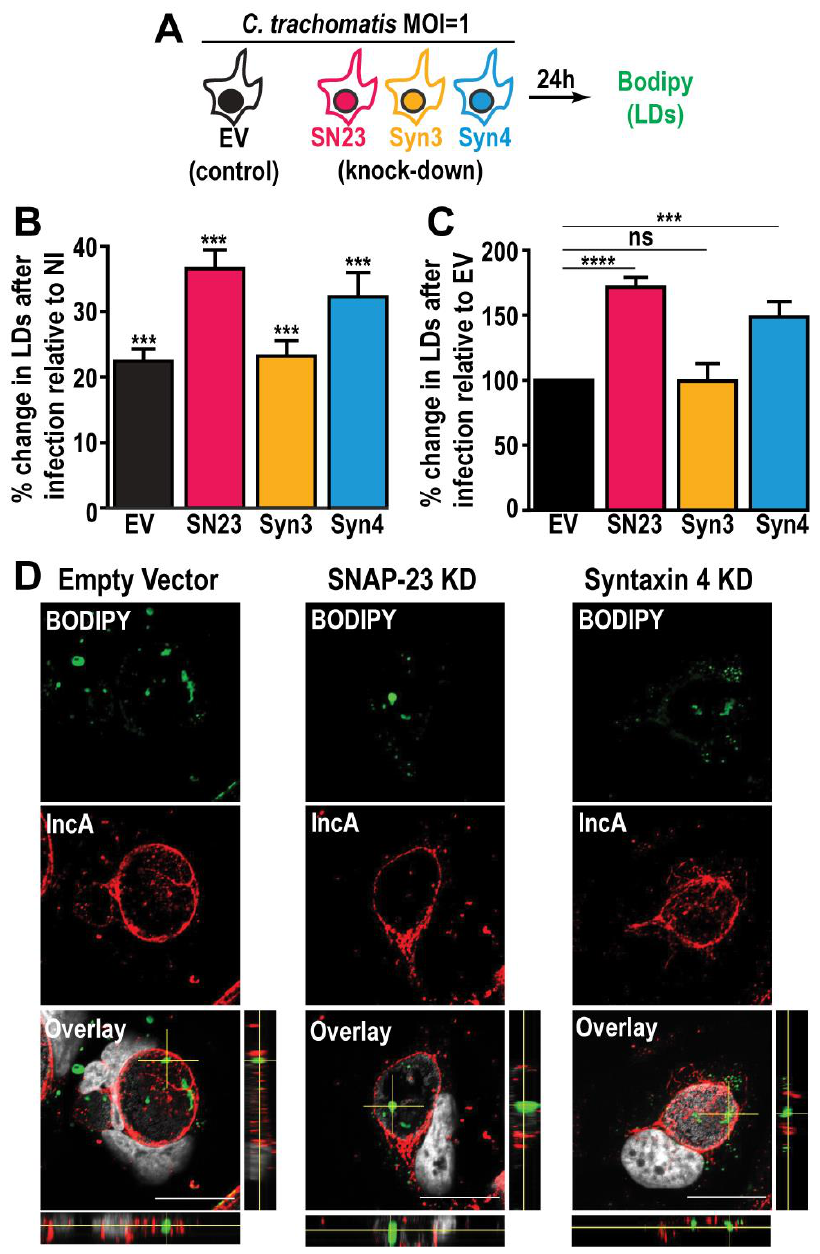
FIGURE 3: Depletion of SNAP-23 and Syn- taxin 4 increases LD content during Chla- mydia infection without affecting LD in- ternalization into the inclusion lumen. (A) Experimental design. SN23 = SNAP-23, Syn3 = Syntaxin 3, Syn4 = Syntaxin 4, LDs = lipid droplets, MOI = multiplicity of infec- tion. (B and C) Cells were either infected with mCherry-expressing C. trachomatis L2 at a MOI of 1 or mock-infected with DMEM for 24 h. The cells were then stained with BODIPY and fixed. BODIPY intensity was measured by flow cytometry. For the in- fected samples only the mCherry-positive population (infected cells) was measured. (B) Graph represents the average percent increase in BODIPY staining relative to non- infected cells from at least three inde- pendent experiments ± the standard devia- tion. Asterisk (***) denotes a p value < 0.001. (C) Graph represents the average increase in BODIPY staining relative to infected empty vector control cells from at least three independent experiments ± the standard deviation. The percent increase in BODIPY staining following infection for the empty vector control cell line was arbitrari- ly set at 100% and represents 121.41% ± 4.92. Values for the KD cells were then normalized to the EV control. Asterisk (***) denotes a p value < 0.001 and (****) denotes a p value <0.0001. ns = not signifi- cant. (D) The indicated cell lines were in- fected with C. trachomatis L2 at a MOI of 0.5 for 30 h. The cells were then fixed and stained with anti-IncA antibody (red) and BODIPY 493/503 (green). Hoechst was used to label DNA (gray). Images are taken from a single plane of confocal z-stacks. next to and below the overlay image, re- spectively. Scale bar = 20 μ m. KD = knock